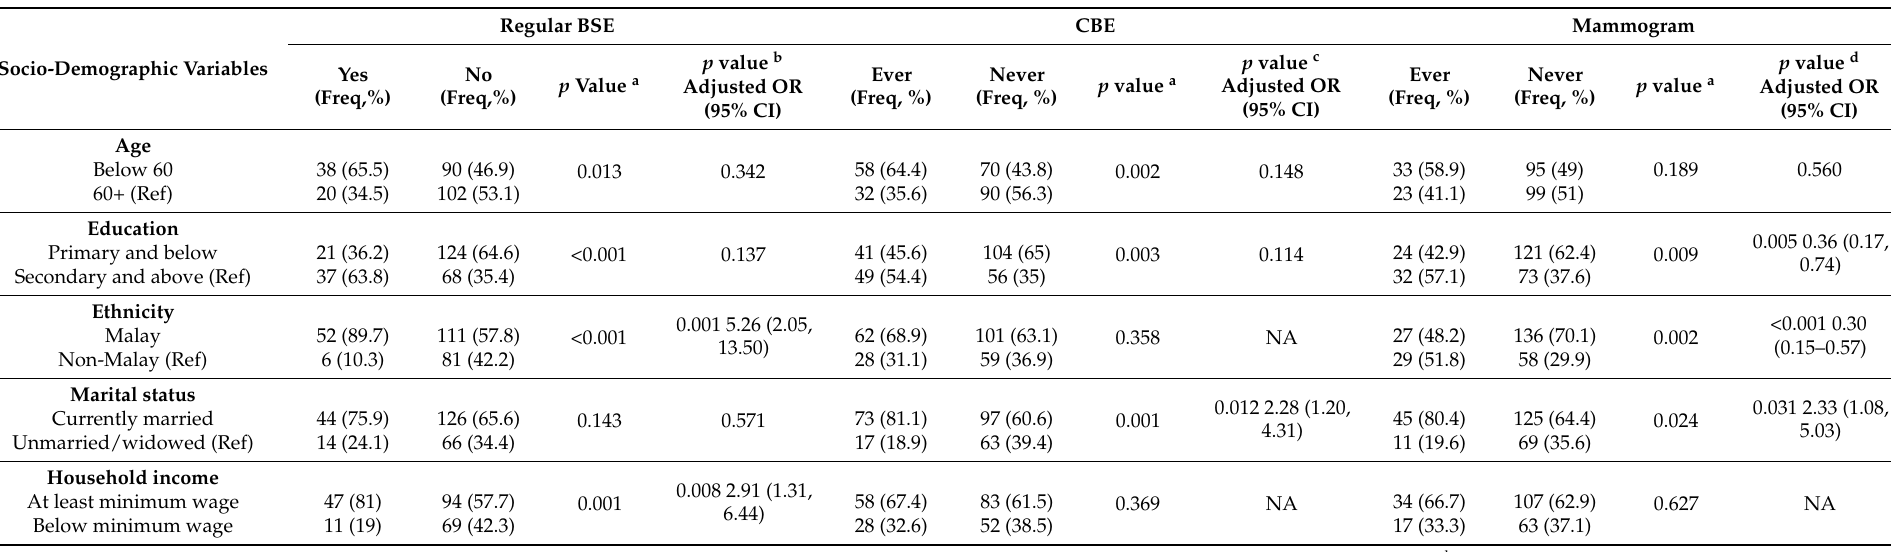
Table 3. Socio-demographic factors associated with breast cancer screening